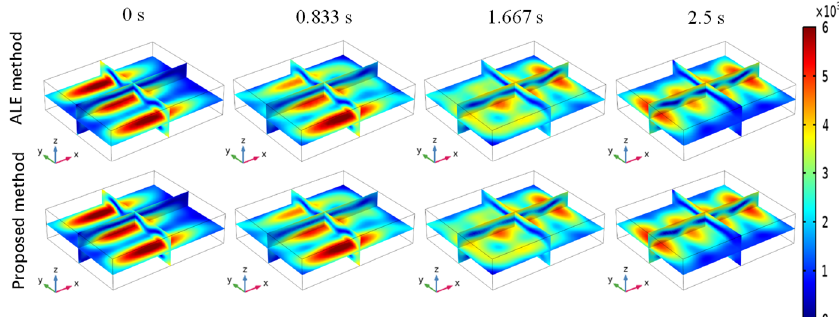
Figure 5. Multislices of the electric field of the potato inside of a microwave oven computed by the ALE method and the proposed method after heating 0 s, 0.834 s, 1.667 s, and 2.5 s (unit: V/m).